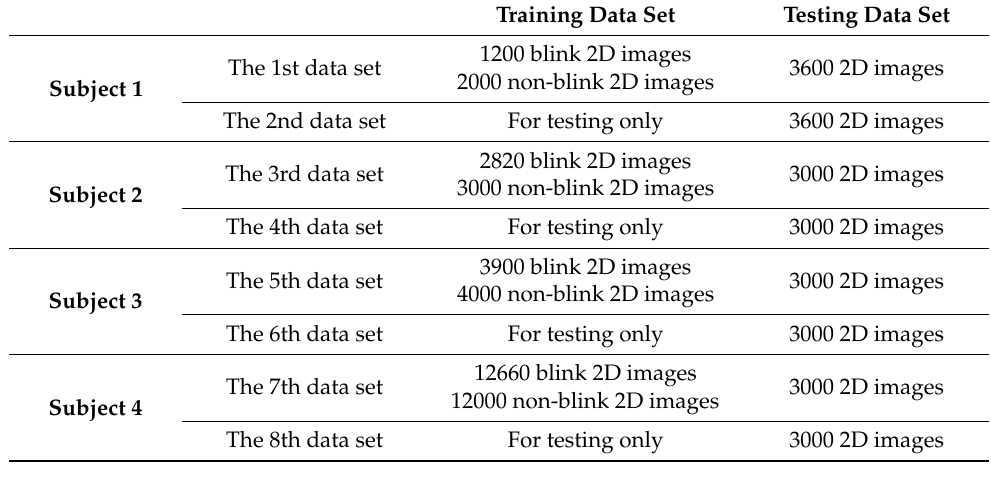
Table 2. The training data set and the testing data set can be obtained from the 8 MEG signal data sets. Every two MEG signal data sets are collected from the same subject. The 1st, 3rd, 5th, and 7th data sets are used to generate 2D images for training and testing. The 2nd, 4th, 6th, and 8th data sets are used to generate 2D images for testing only. Training Data Set Testing Data Set